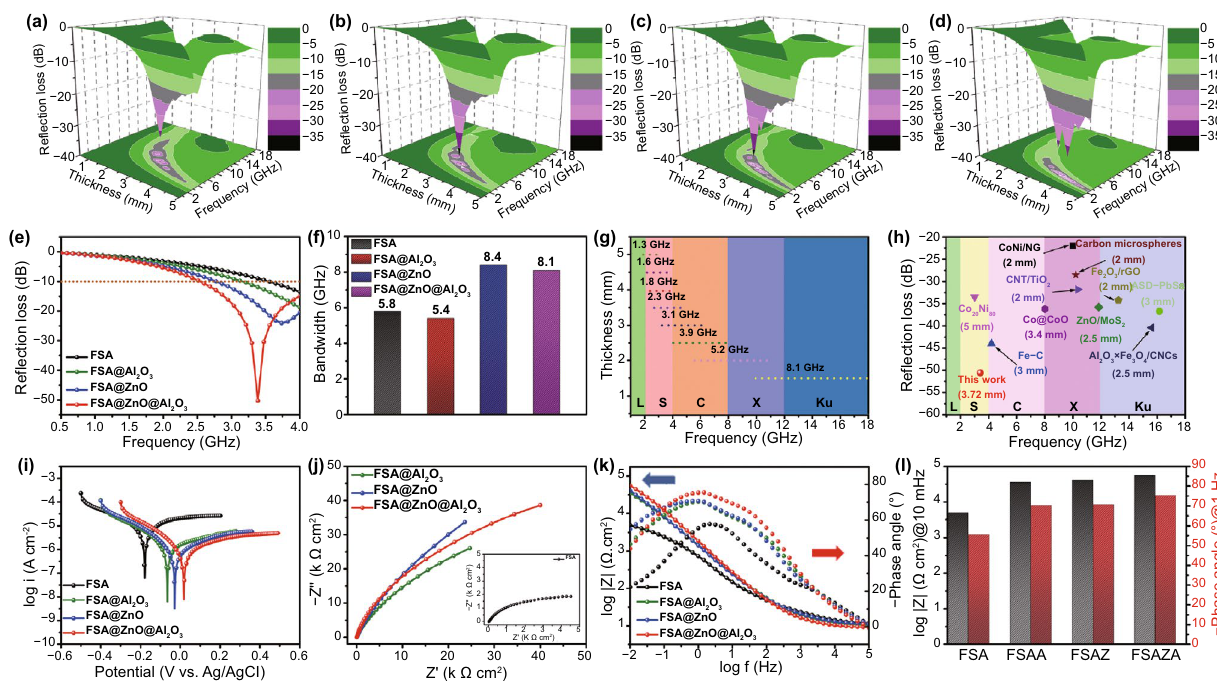
Fig. 2 3D RL maps of as-prepared absorbers of d at 0.5–5.0 mm in 0.5–18 GHz: a FSA, b FSA@Al 2 O 3 , c FSA@ZnO, d FSA@ZnO@Al 2 O 3 . e RL curves of FSA-based samples at a thickness of 3.72 mm in 0.5–4.0 GHz, f the effective absorption bandwidth at a thickness of 1.5 mm, g effective absorption range of FSA@ZnO@Al 2 O 3 at different layer thicknesses, h performance comparison of several microwave absorbers which have attracted large attention, including Co 20 Ni 80 [45], Fe–C [46], Co@CoO [47], CNT/TiO 2 [48], CoNi/NG [49], Carbon microspheres [50], Fe 2 O 3 /rGO [51], ZnO/MoS 2 [52], Al 2 O 3 × Fe 3 O 4 /CNCs [18], ASD-PbSs [53]. i potentiodynamic polarization curves, j Nyquist plots, k Bode plots, l impedance at 10 mHz and phase at 1.0 Hz of FSA, FSA@Al 2 O 3 (FSAA), FSA@ZnO (FSAZ), and FSA@ZnO@Al 2 O 3 (FSAZA) gradi- ent structure in 5.0 wt% NaCl